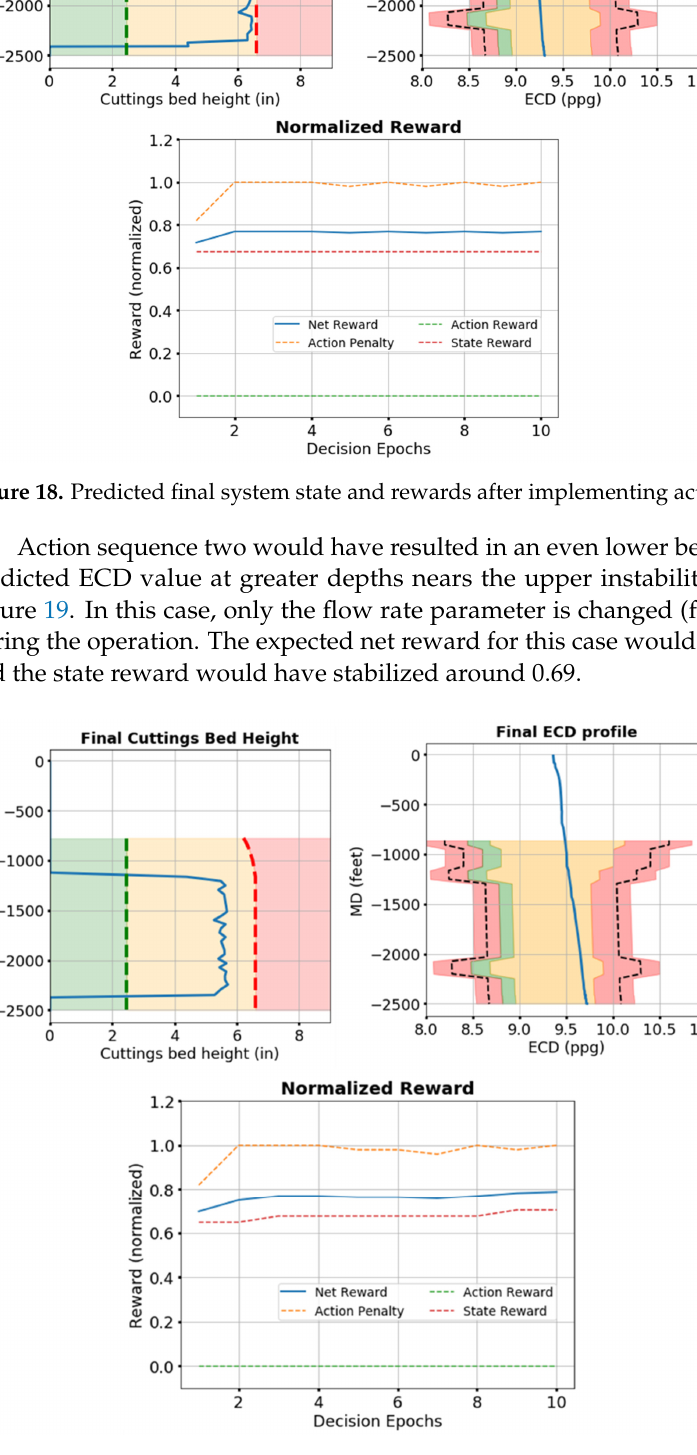
Figure 19. Predicted final system state and rewards after implementing action sequence two.